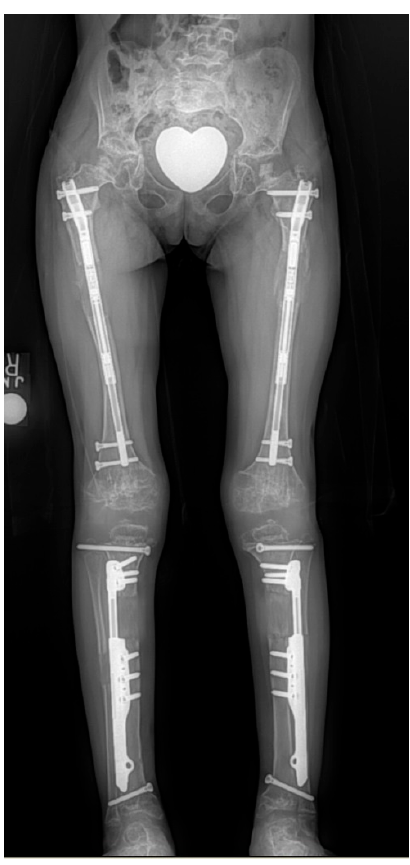
Figure 9. Radiograph showing InFix lengthening in a 12-years-old child with pseudo-achondroplasia using two implantable lengthening nails in the femurs and two implantable lengthening plates in the tibias.